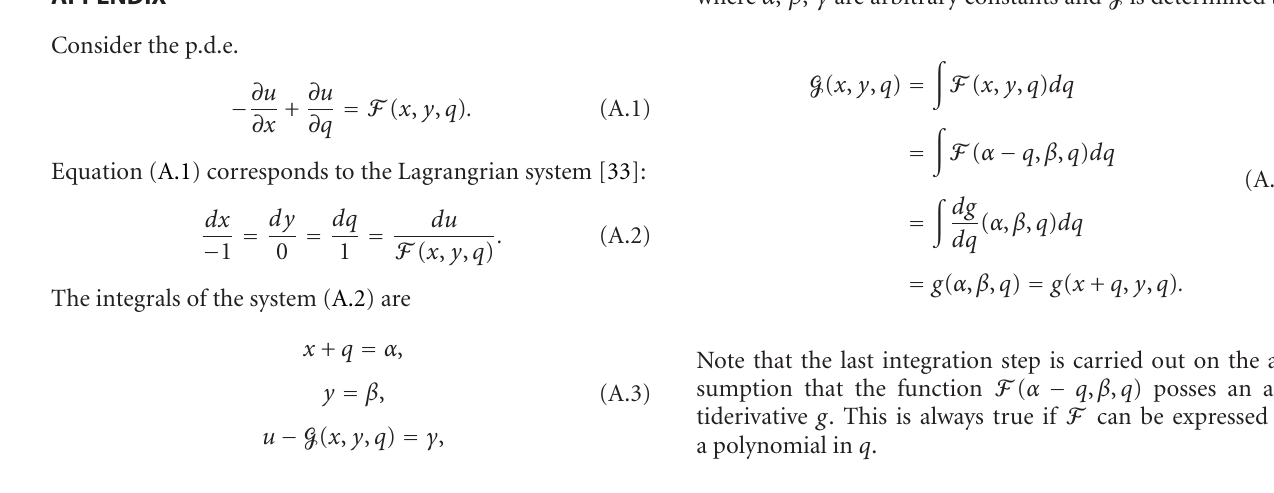
Figure 14: The behavior of the prerolling region on a variation of the ball radius for di ff erent spin creepages ( μ = 0.5).